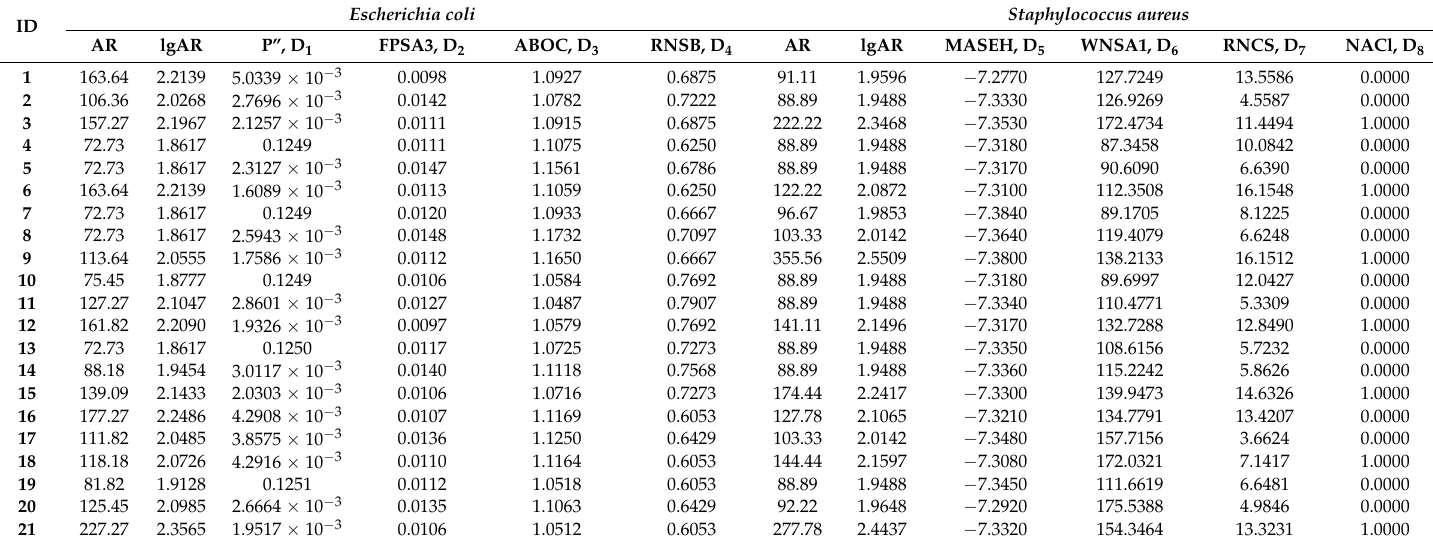
Table 1. The antibacterial activity rates (AR) and the value of molecular descriptors for the best QSAR model against E. coli and S. aureus